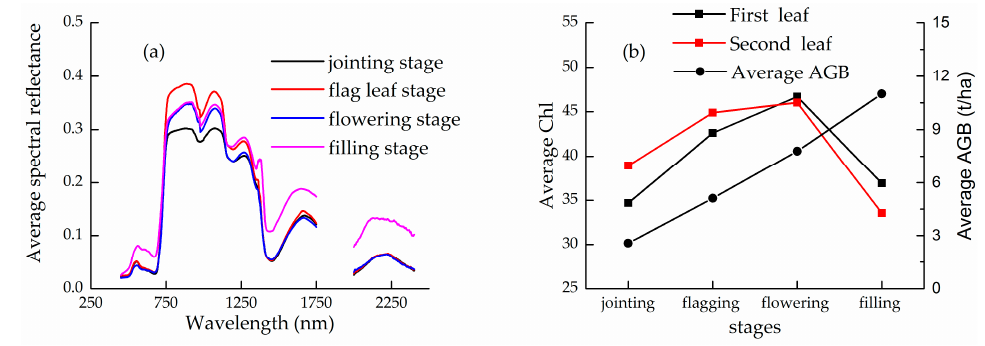
Figure 2. ( a ) Average hyperspectral reflectance spectrum for the four growing stages. ( b ) Average Chl and above-ground biomass (AGB) for the four growing stages.